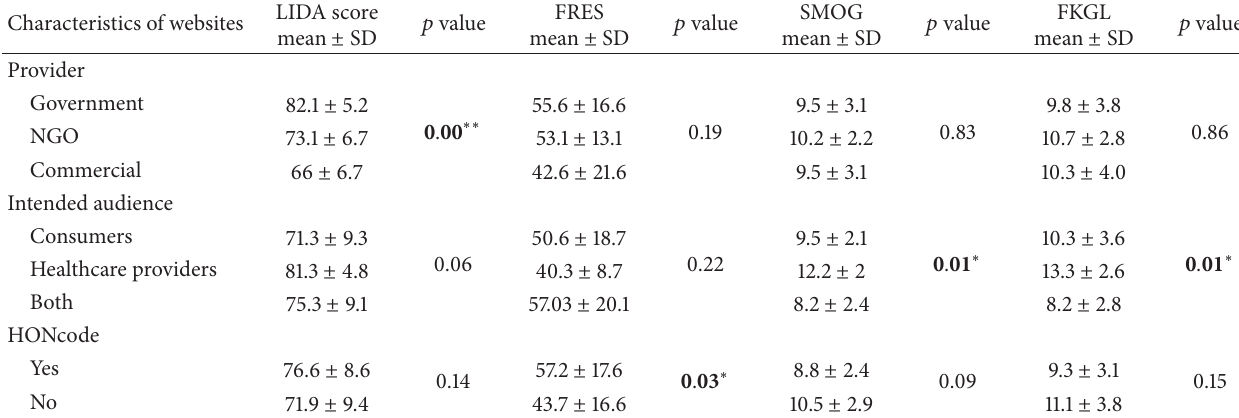
Table 4: Association between characteristics of websites with mean LIDA and mean readability scores. LIDA Characteristics of websites